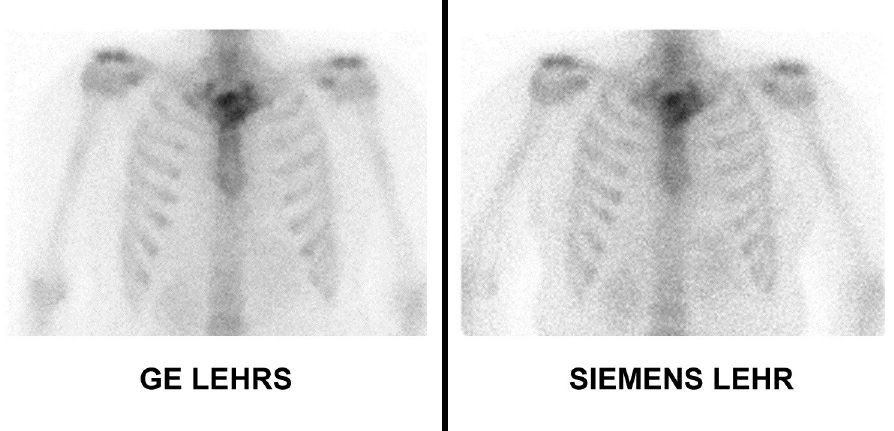
Fig 5. Planar acquisitions in bone scintigraphy.